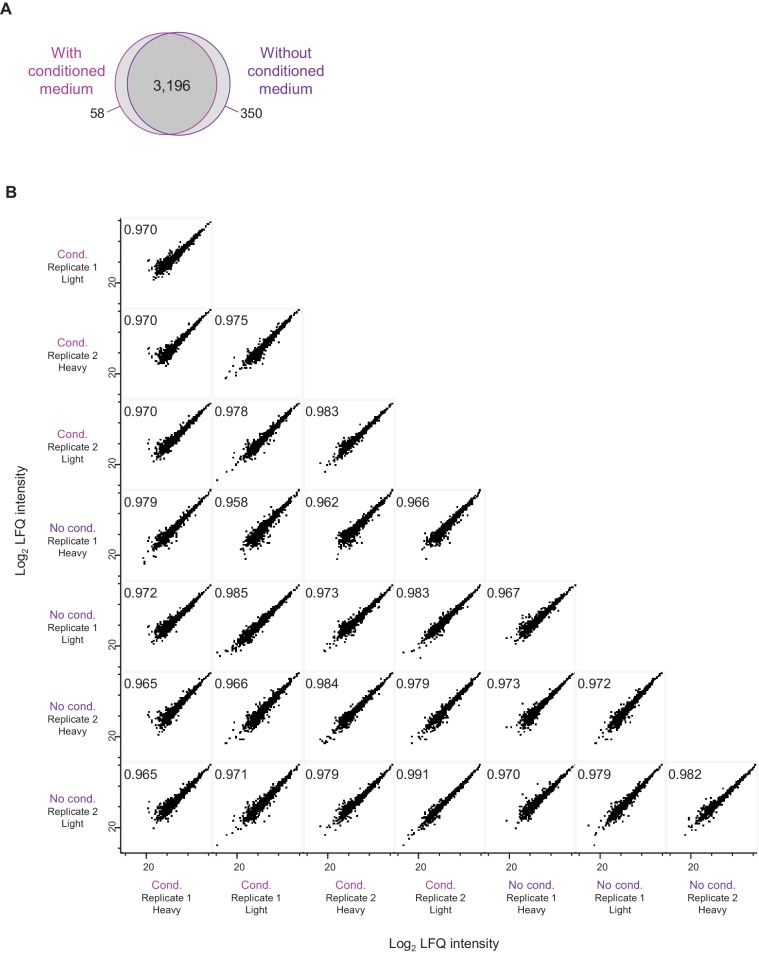
Comparison of neuron-enriched cultures with and without conditioned medium.(A) Venn diagram shows the number of detected protein groups in neuron-enriched cultures with and without conditioned medium. (B) Comparison of relative protein abundances. Log2 LFQ intensities are compared between independent samples obtained from neuron-enriched cultures with and without conditioned medium. The Pearson correlation (top left of each diagram) is very high for all pair-wise sample comparisons (≥0.962).